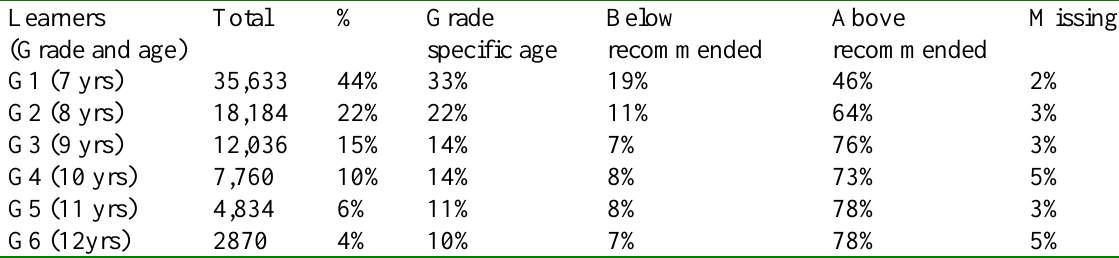
Above recommended